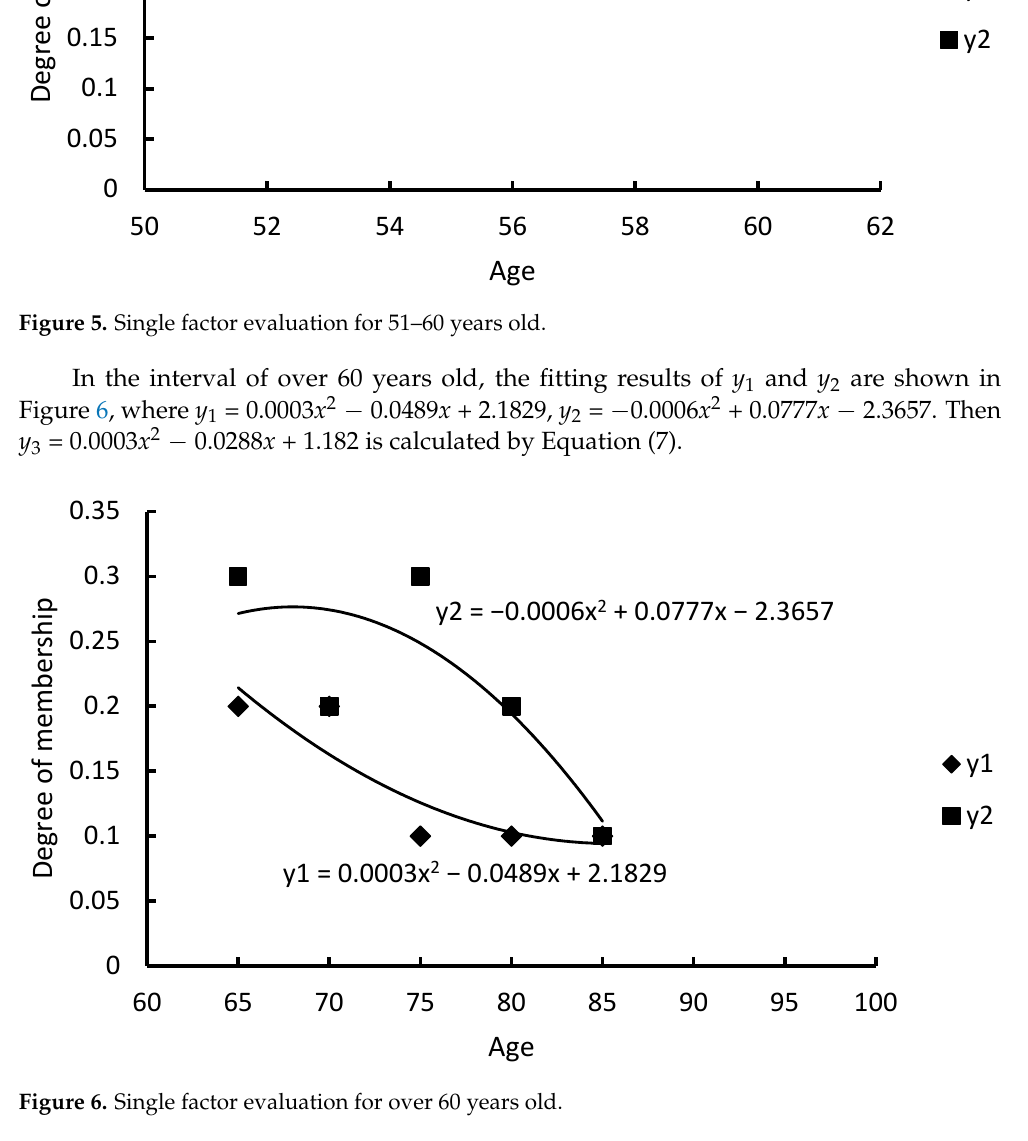
Figure 6. Single factor evaluation for over 60 years old.